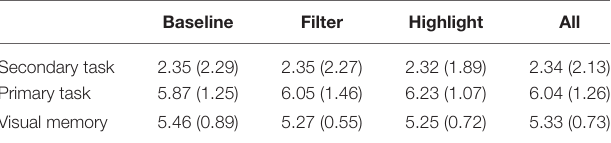
TABLE 7 | Experiment 4, Mean (Std), in secondary task of number of words remembered correctly in serial recall task out of maximum 8, in primary task of plan questions answered correctly out of maximum 10, and of visual